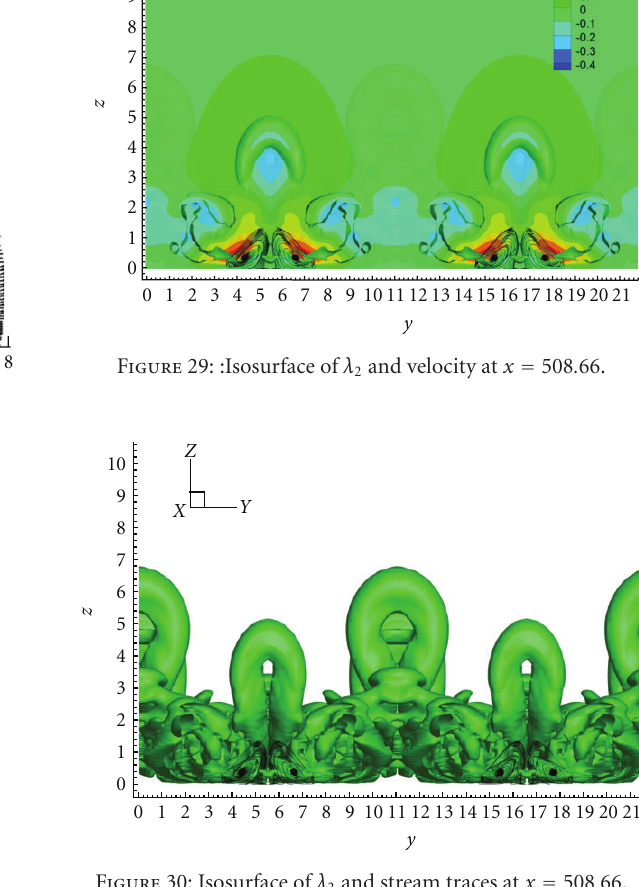
Figure 30: Isosurface of λ 2 and stream traces at x = 508 . 66.